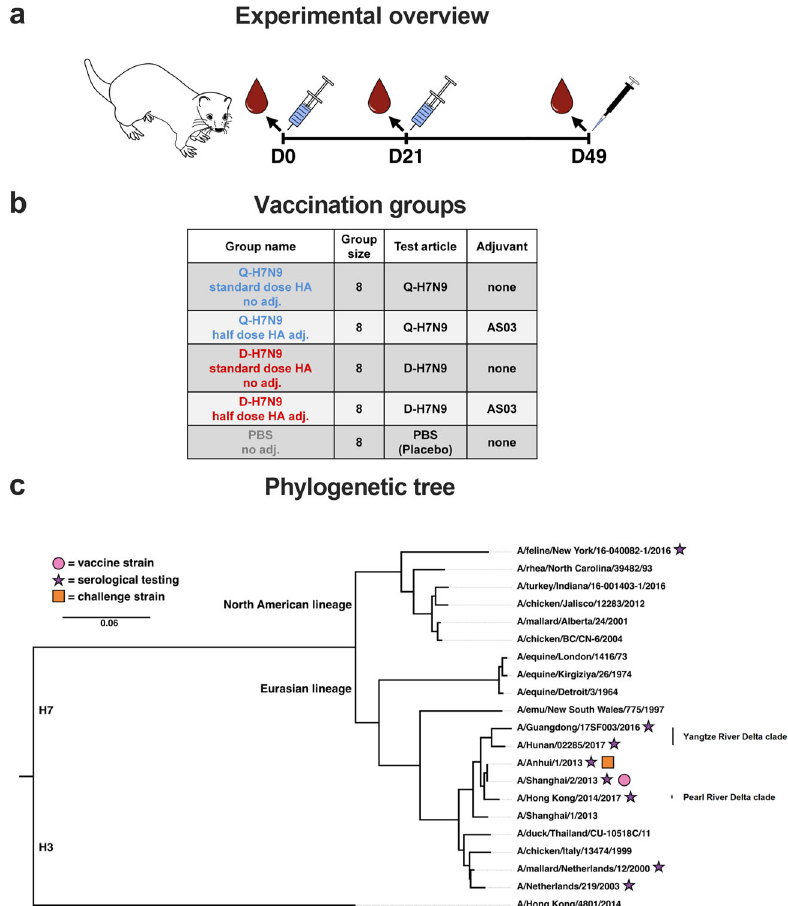
Fig. 1 Immunization overview and phylogenetic tree. a Experimental overview. Ferrets were immunized on day 0 and day 21 with AS03- adjuvanted or non-adjuvanted H7N9 split virion vaccines. The placebo group received PBS. The animals were bled for serology on days 0, 21, and 49. On day 49, the animals were challenged with a wild-type H7N9 virus. b Treatment groups. The fi ve different treatment groups are shown. Two groups ( n = 8/group) were immunized twice with non-adjuvanted standard-dose Q-H7N9 or D-H7N9 vaccine, respectively. Two groups ( n = 8/group) were immunized twice with AS03-adjuvanted half-dose Q-H7N9 or D-H7N9 vaccine, respectively, and eight animals were injected with PBS. c Phylogenetic tree. North American lineage and Eurasian lineage H7 HAs are shown with H3 HA (A/Hong Kong/4801/2014) as an outgroup. The vaccine strain H7 HA is indicated with a pink closed circle, the H7 strains used for serological testing (HI, VN, ELISA) are highlighted with stars and the H7N9 challenge virus is marked with a square. The scale bar (0.06) indicates the percent difference based on amino acid